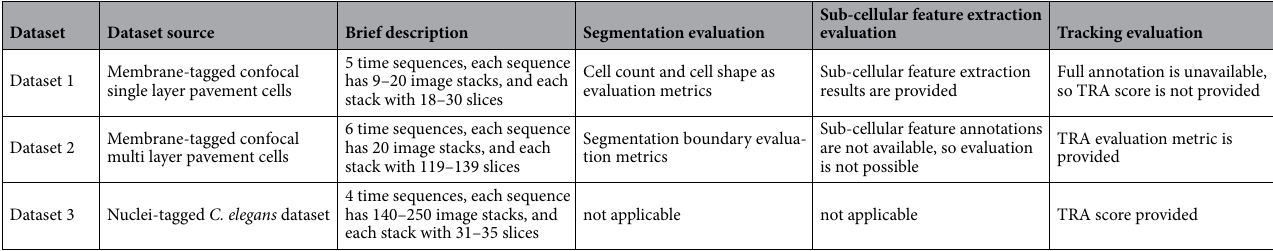
Table 1. Datasets summary and usage (note that TRA definition will be described in “Results”